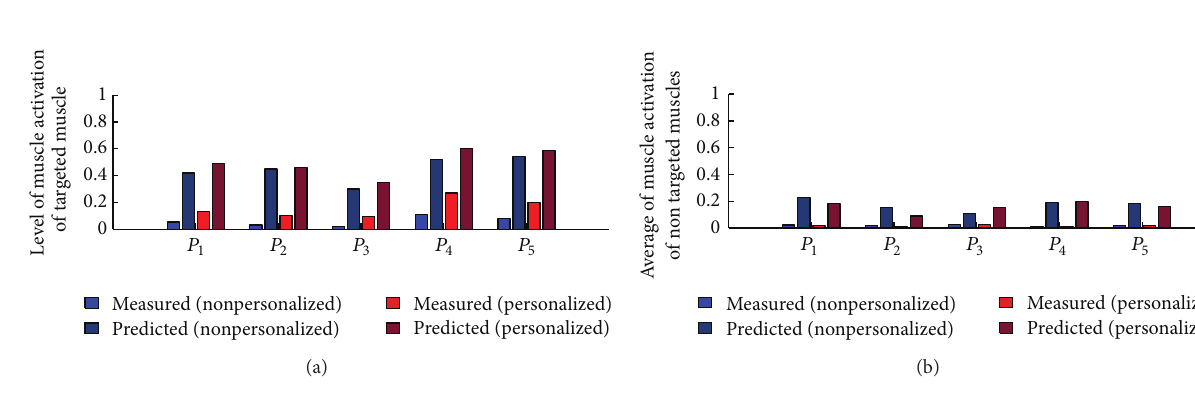
Figure 25: Level of muscle activation (Sub. I).